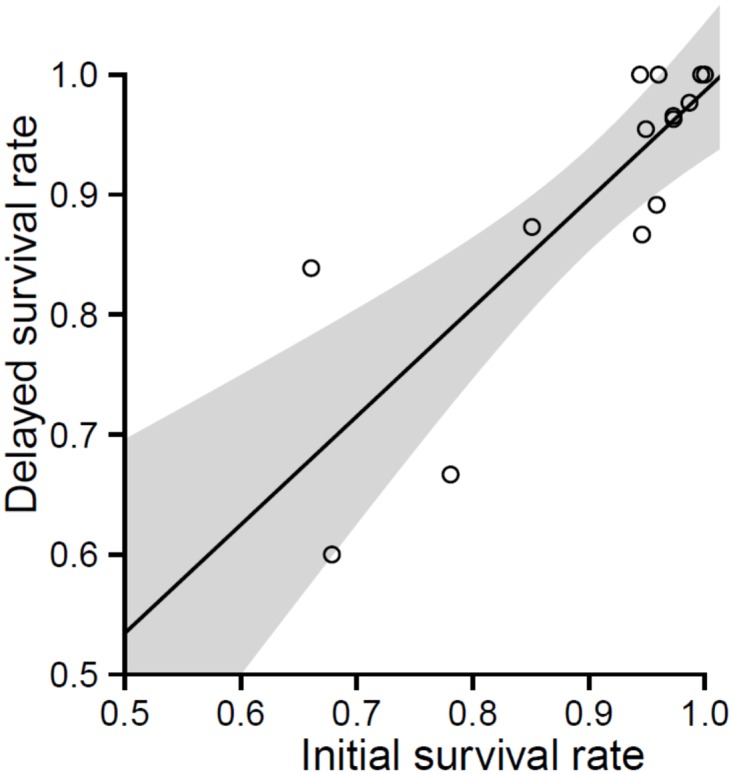
Linear relationship between initial survival rate and delayed survival rate.Shaded area represents 95% confidence interval.